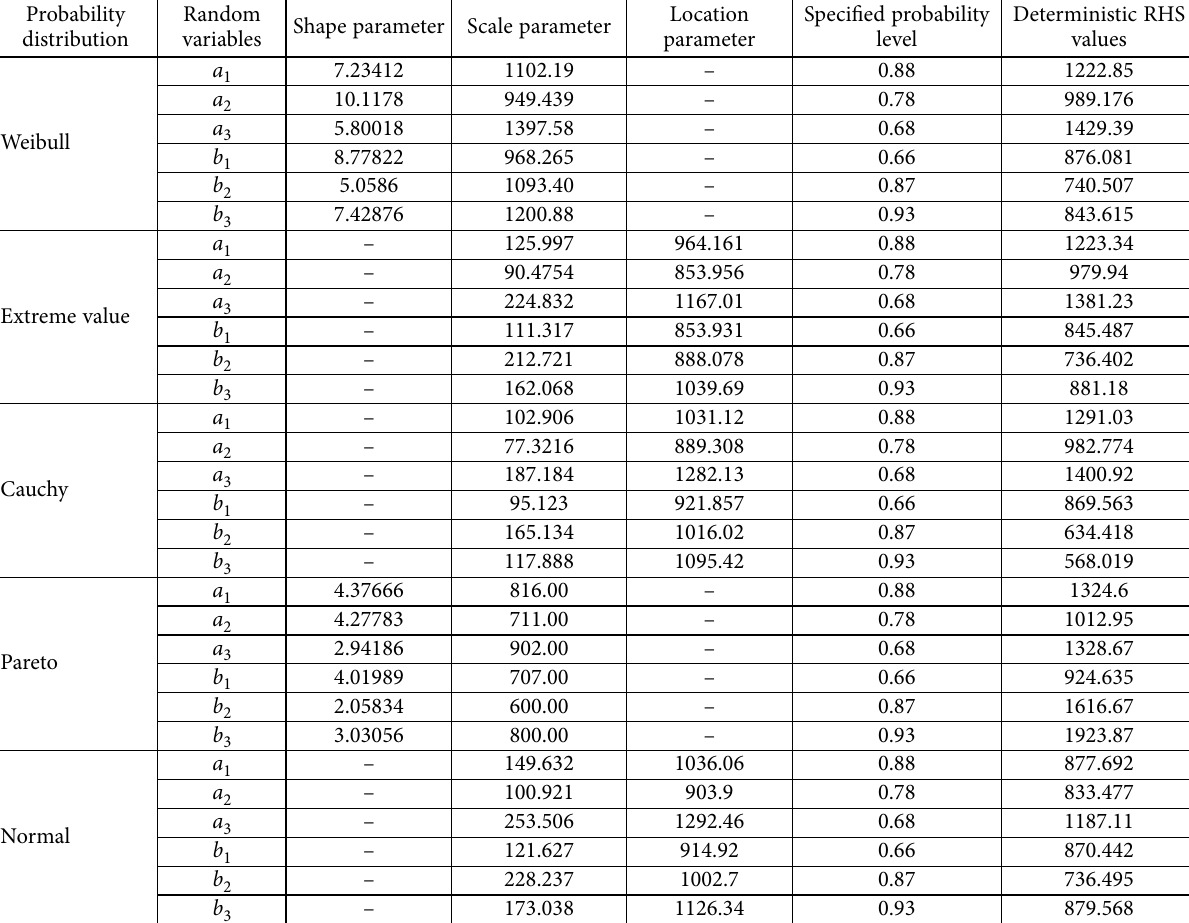
Table 10. Values of parameters with